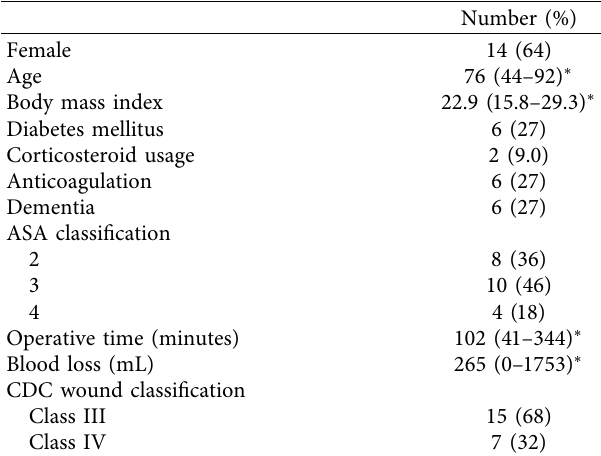
Table 1: Patient